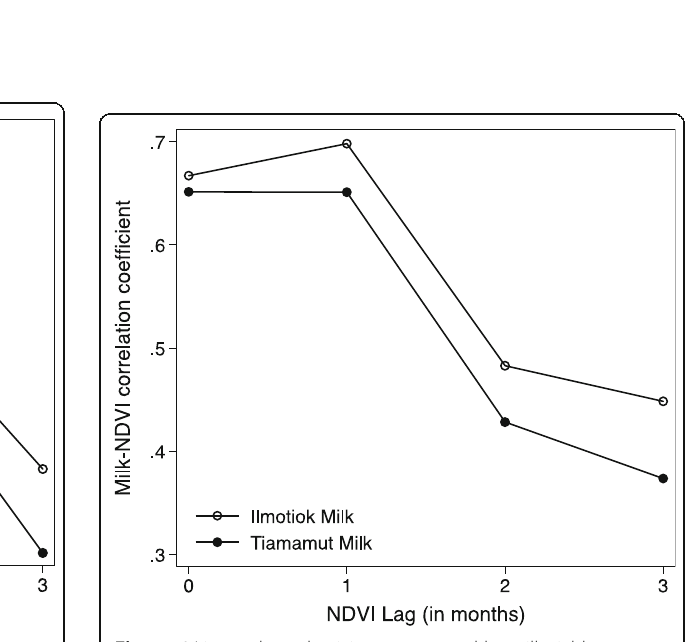
Figure 6 Livestock productivity, as measured by milk yields, correlates with a one-month lag in NDVI values ( R 2 = 0.65, p < 0.05). Combining this result with that of Figure 4 means it takes one month for the grass to green up and a second month for stock to feed on this improved forage before productivity reaches its